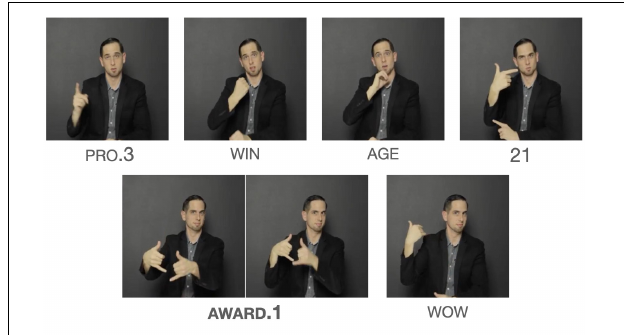
FIGURE 3 | An instance of AWARD .1 in an apparently non-first person reading. Images produced with permission, source information available in the Supplementary Material .